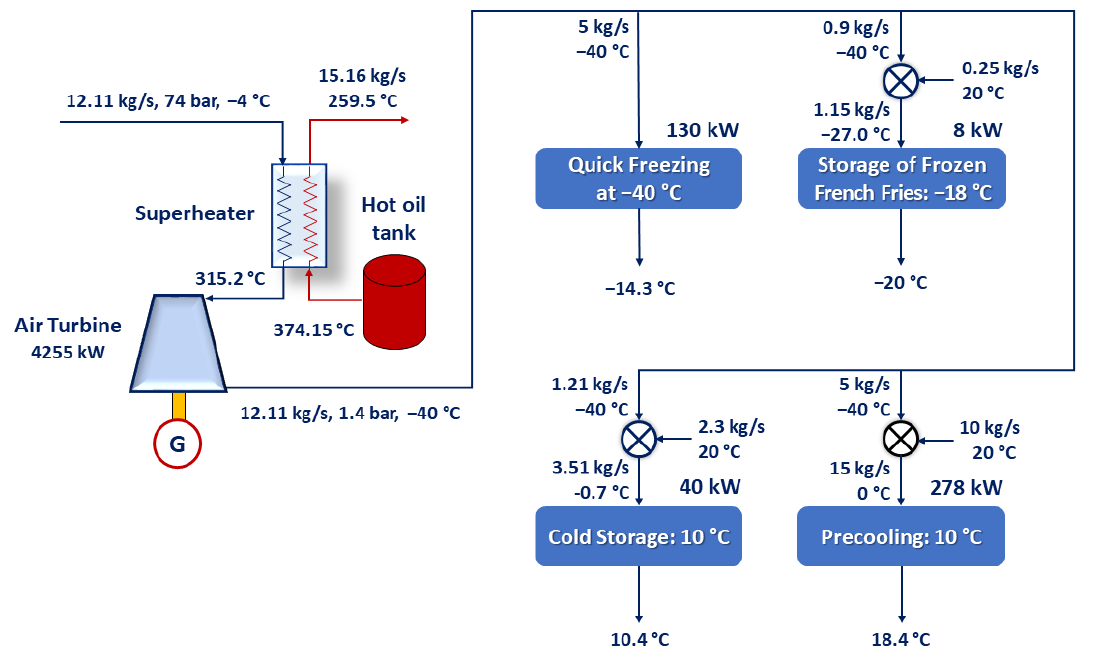
Figure 6. Possible arrangement of the cold air distribution among the consumers along the two identical French fry production lines.